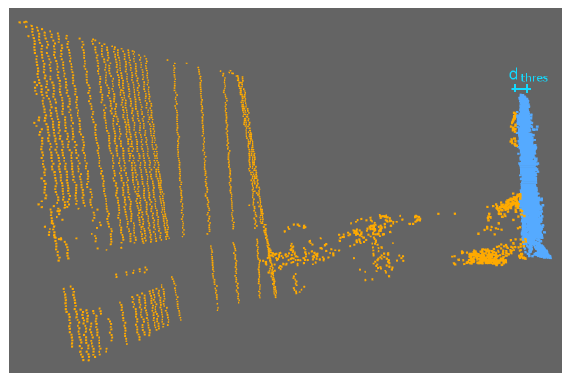
Figure 6: Cleaned scan from the side of the mirror plane. Points on the mirror plane are turquoise, and points behind the mirror plane are orange. The ”thickness” of the mirror depends on the chosen threshold.